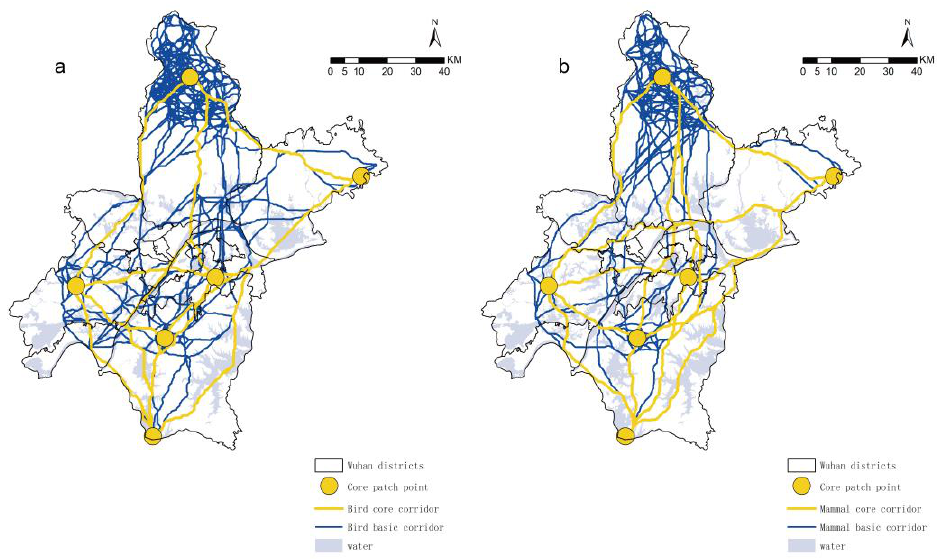
Figure 6. Corridor network priority analysis. ( a ) Birds, ( b ) Small mammals.